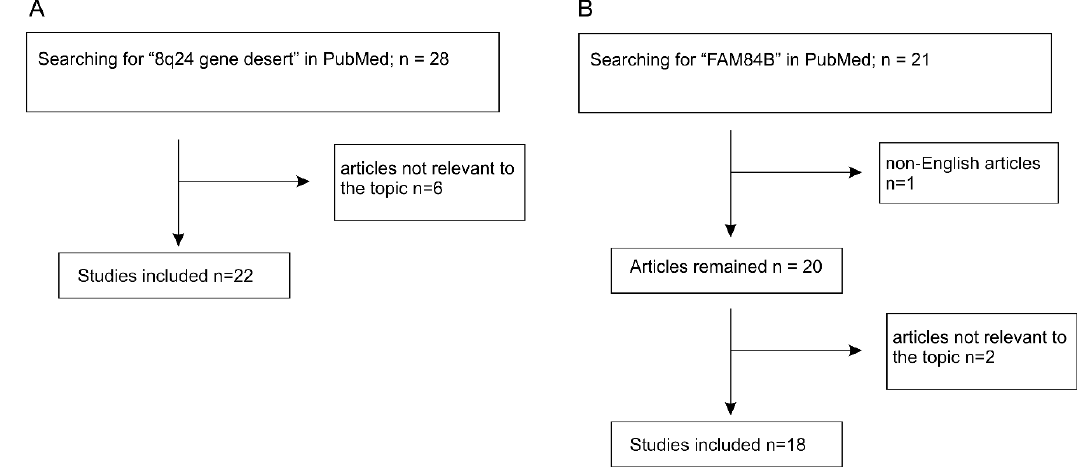
Figure 2. Systemic literature searching conditions and selection of articles for review.